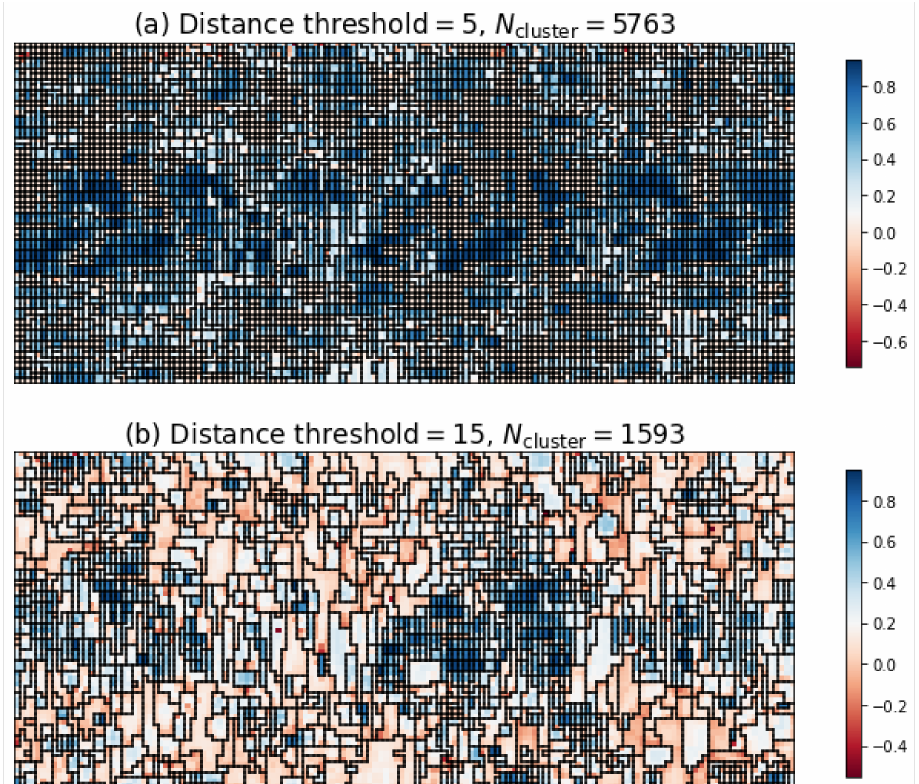
Figure 6. ( a ) the optimal segmentation judging from the silhouette scores and Davies-Bouldin scores; ( b ) the optimal segmentation judging from the Calinski-Harabasz scores. The coloring is given by the silhouette coefficients. The fatigue loading is along the vertical direction. The grid points were spaced by 2 µ m vertically and